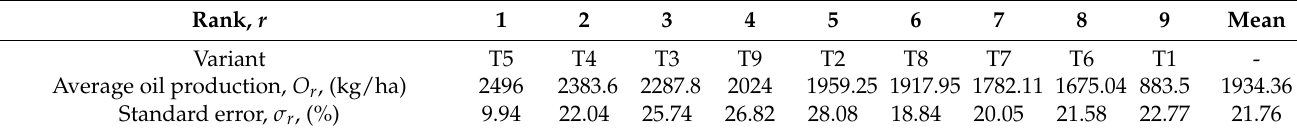
Table 11. Values for average rapeseed oil production, in descending